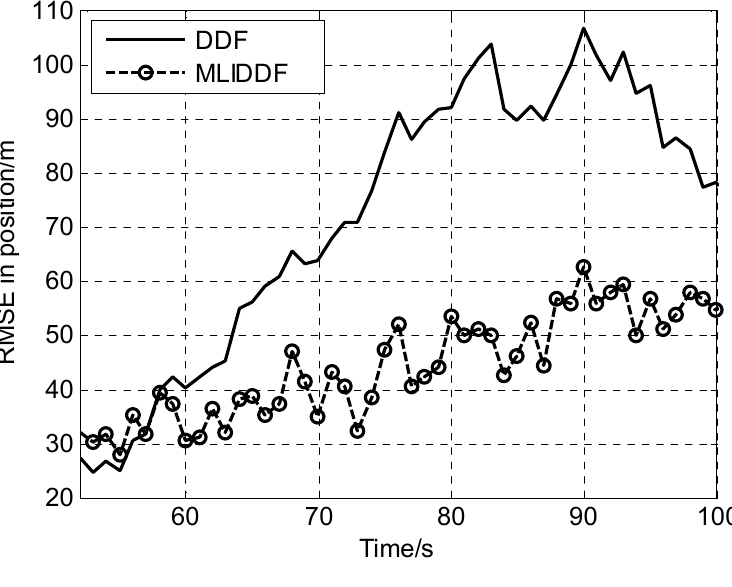
Figure 1. RMSE in position for DDF and